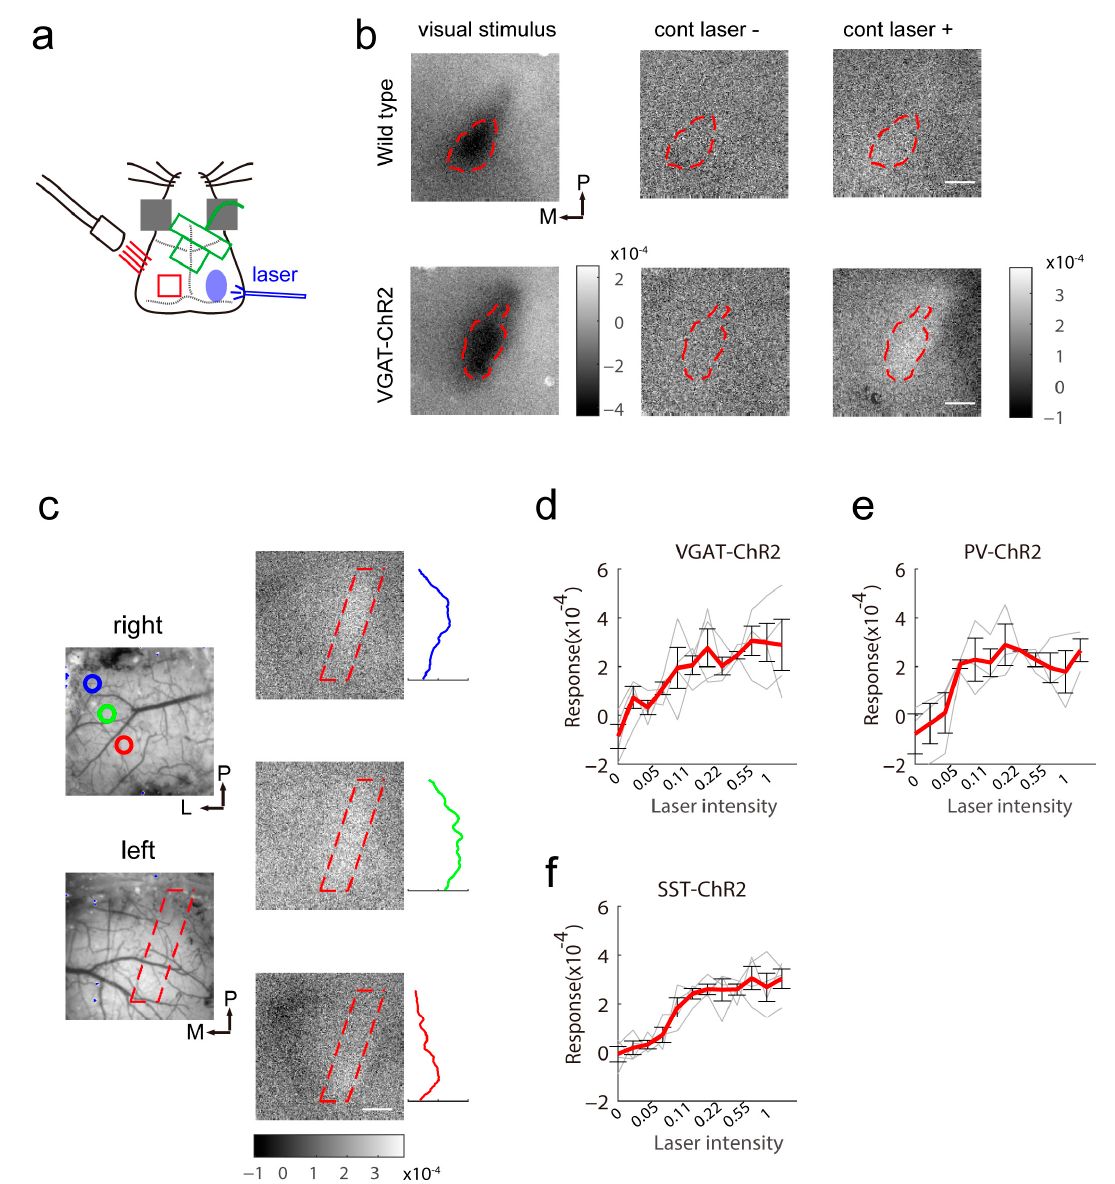
Figure 2. Reduced spontaneous activity elicited by contralateral light stimulation. ( a ) Schematic of intrinsic signal optical imaging and laser stimuli. The intrinsic signal optical imaging recorded the signal of the left visual cortex and light stimulation was located in the right visual cortex. ( b ) Response map induced by visual stimuli and contralateral light illumination in wild-type ( top ) and VGAT-ChR2 ( bottom ) mice (16 repeats). The binocular area was determined by the response evoked by a visual stimulus at the binocular receptive field ( left ). The spontaneous activity map with ( right ) or without ( middle ) contralateral light stimulation is illustrated. The scale bar is 0.2 mm. ( c ) The spontaneous response depression induced by contralateral light was topologically arranged in VGAT-ChR2 mice. The colored circles label the site for stimulation within the binocular area. The response map on the right shows the spatial activation pa tt ern. The colored response curve was calculated from the region of interest outlined by the red dashed line in the response map. The scale bar is 0.2 mm. ( d – f ) The amplitude of the response of the left visual cortex depends on the laser intensity in VGAT-ChR2 mice (d, n = 4), PV-ChR2 mice (e, n = 3) and SST-ChR2 mice (f, n = 4).